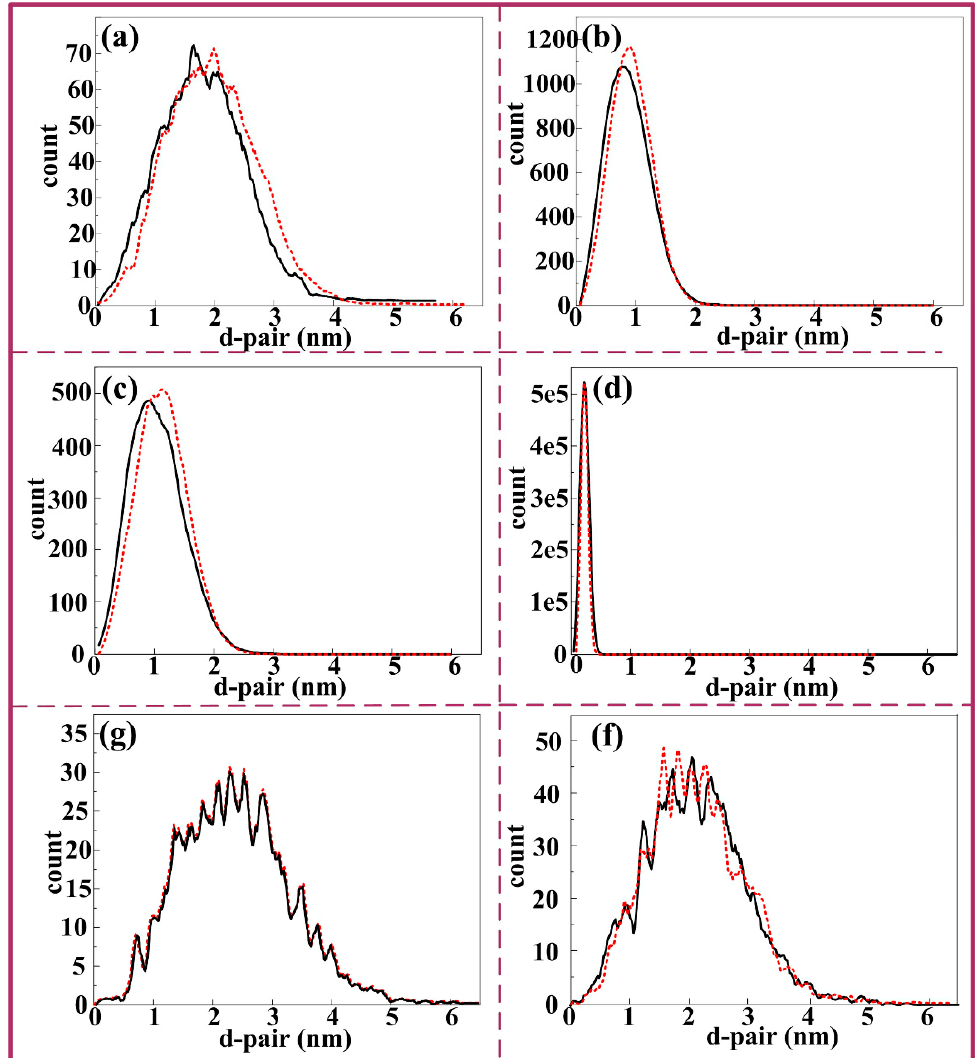
Figure 7. The nearest neighbor distribution of different elements in S + EA sample: ( a – f ) Cu, Mg, Si, Al, Mn, and Cr. Table 3. The chemical composition of each cluster counted by IVSA software.